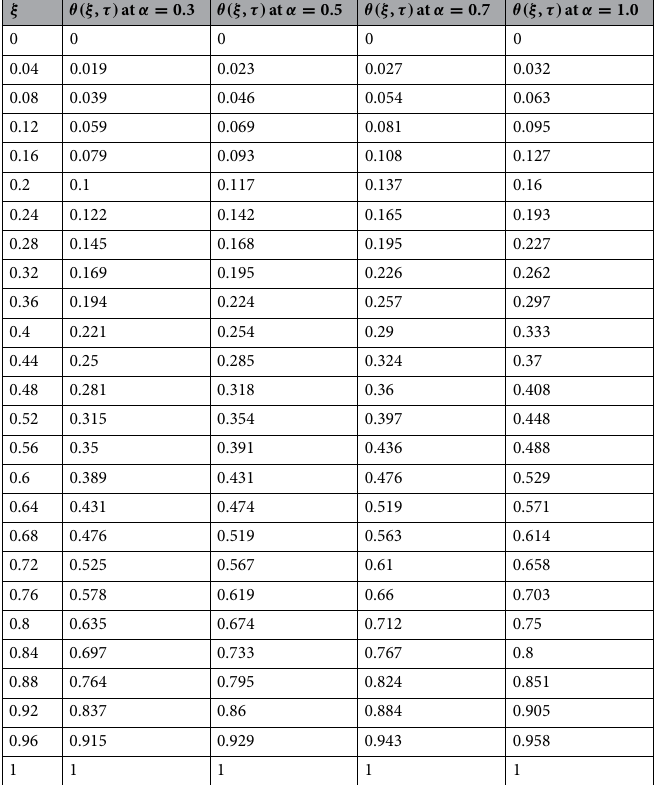
Table 9. Variations in temperature profile against ξ if f (τ) = 1 for different values of α .